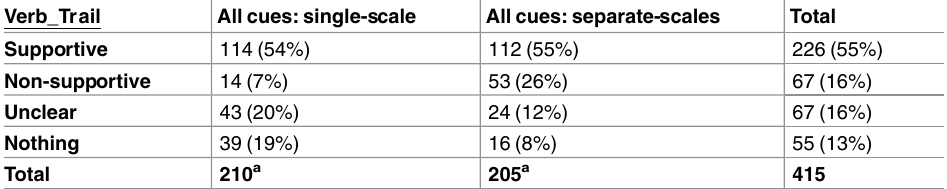
Table 6. Frequency and proportion of codesassignedto verbalizationsaboutthe trailingdiagnosis (Verb_Trail). Verb_Trail